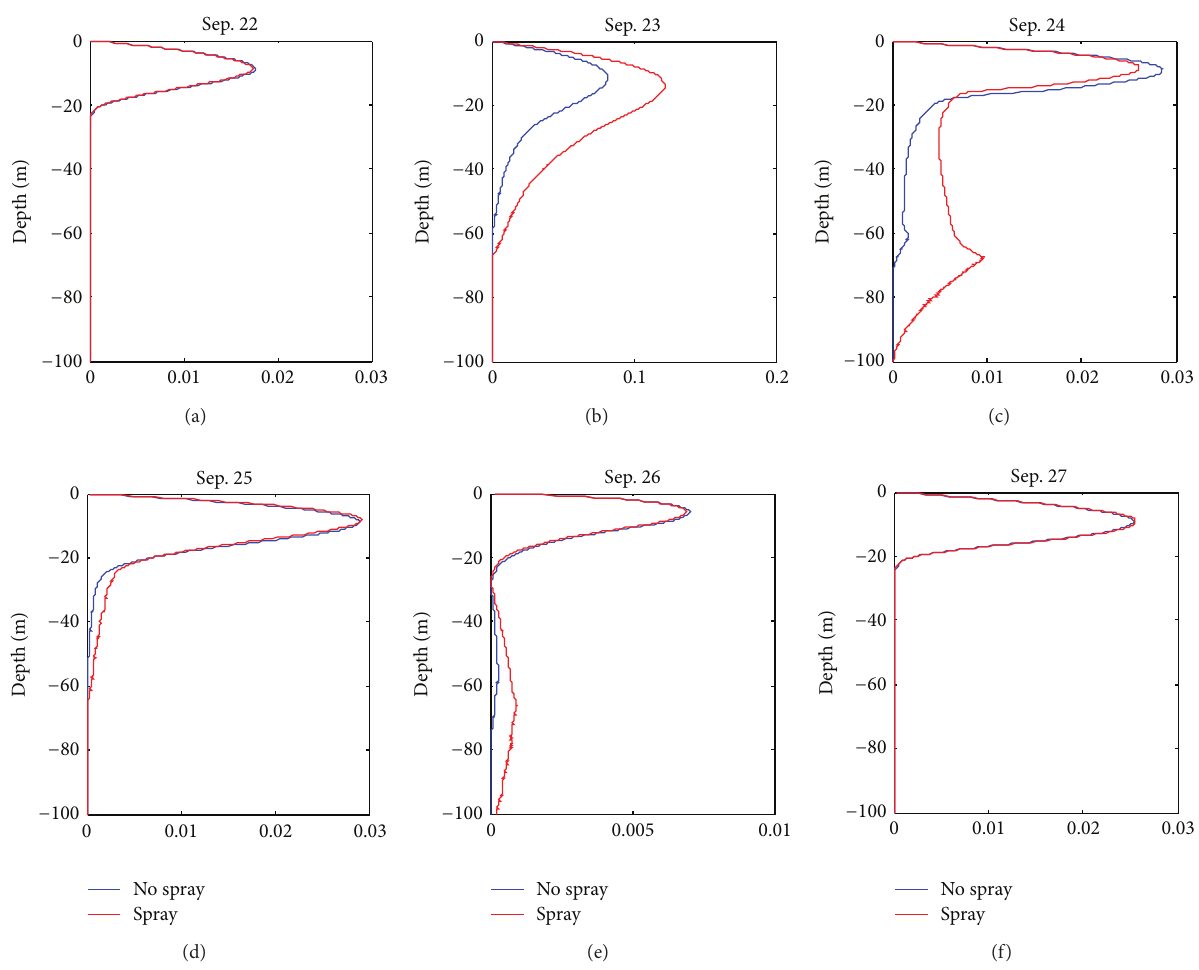
Figure 14: Upper 100m 𝐾 ℎ daily profiles simulated by Test 1 (no spray, blue curves) and Test 2 (spray, red curves) on September 22–27 ((a)–(f)),